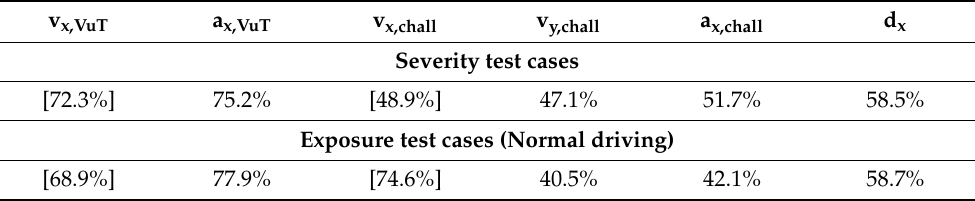
Table 7. Coverage ratios of Monte Carlo test cases.